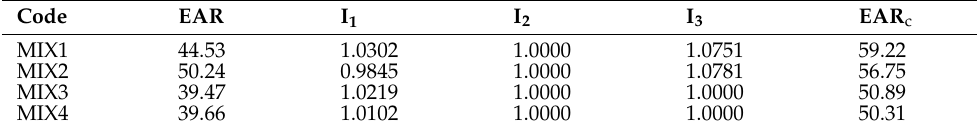
Table 11. Application of the coefficients to the EAR